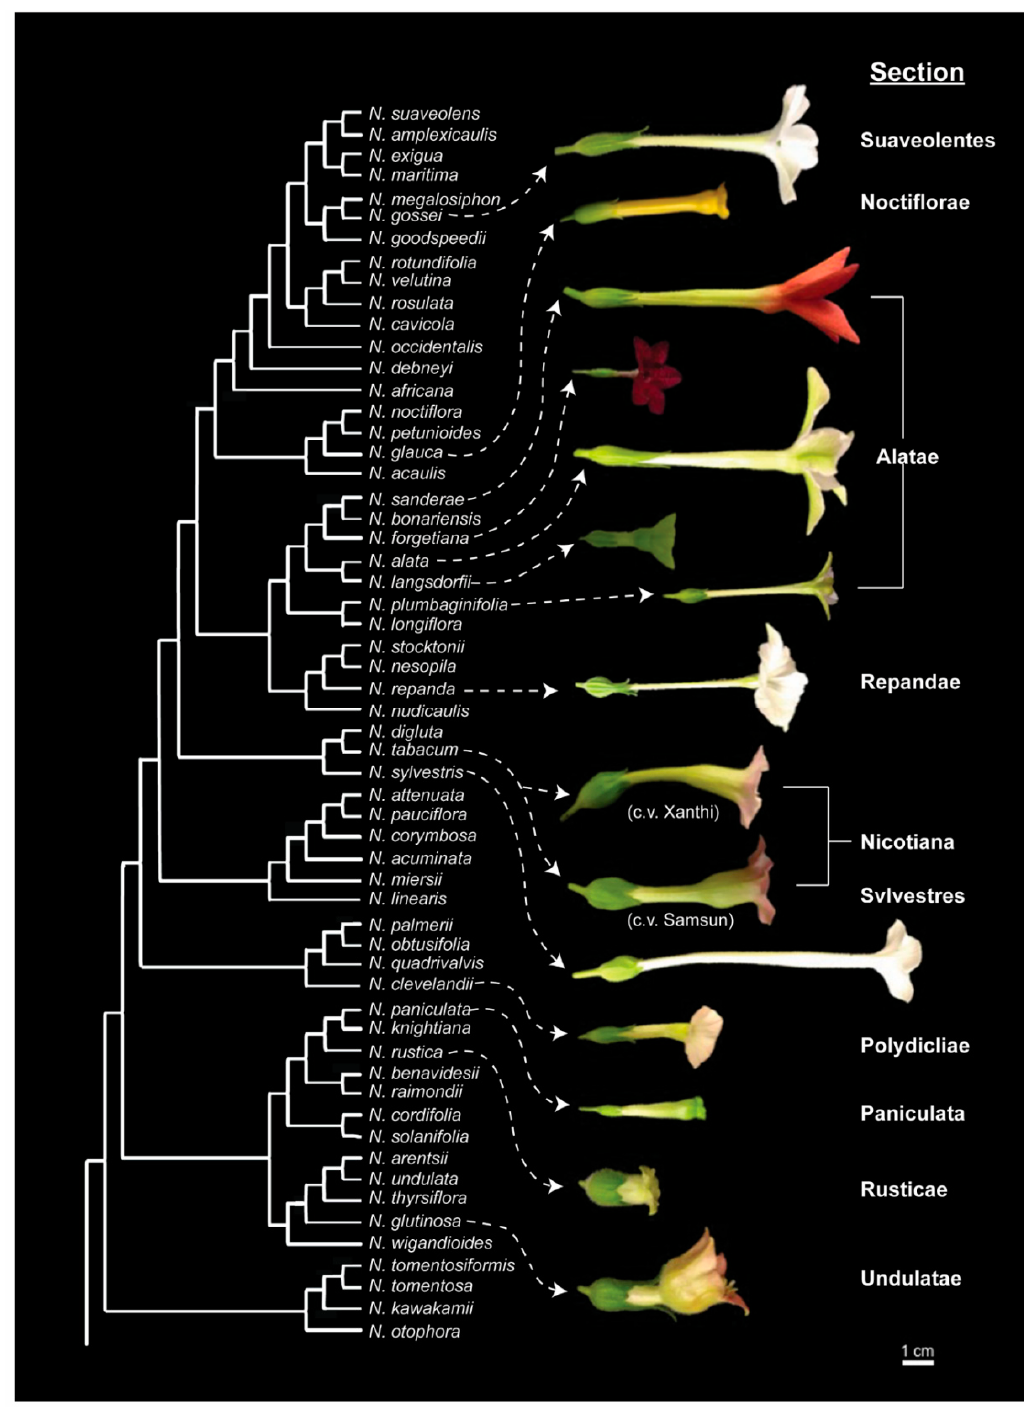
Figure 1. Flowers of the fifteen Nicotiana species studied herein, organized by phylogeny within the genus. Phylogenetic tree is based on the analysis of Clarkson et al. [27].